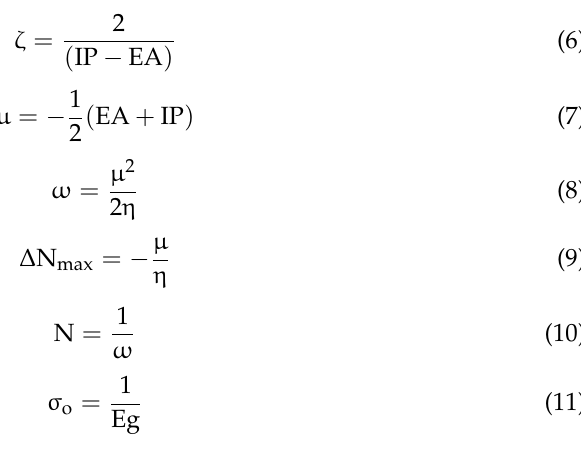
Table 1. Various physical parameters of the binary mixtures ( α -cubebene–water (a), β -caryophyllene–